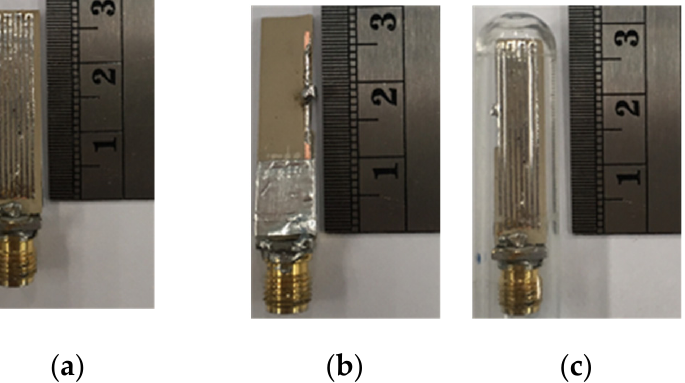
Figure 12. Prototype of the MICS/ISM meander-line microstrip antenna: ( a ) front view, ( b ) rear view, ( c ) in the glass pod. Table 5. The concentrations of syrup, salt, and water in nine experimental mixtures of equivalent liquid.